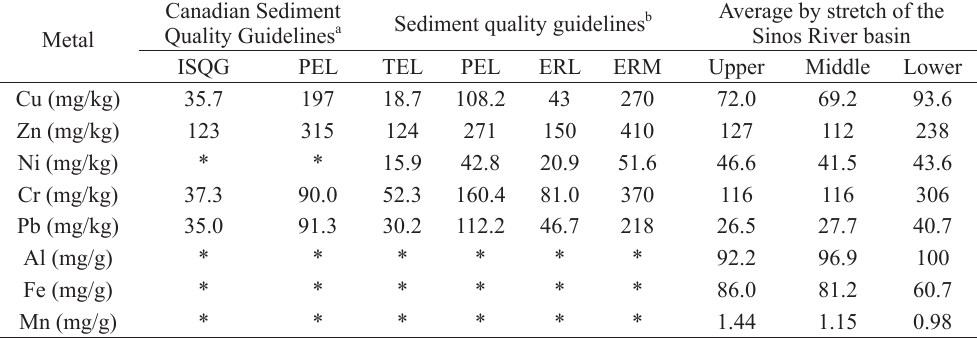
Comparison of average metal concentrations (mg/kg) in sediments of three stretches of the Sinos River basin with sediment quality guidelines